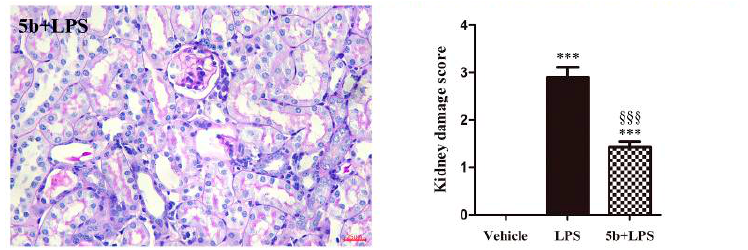
Figure 2. Effect of 5b on lipopolysaccharide (LPS)-induced acute kidney injury (AKI) mice. Periodicacid-Schiff (PAS)-stained sections showed no damage in the vehicle group, the tubular injury in LPS group, and attenuated tubular injury in the 5b + LPS group. Note there were many dilated tubules (asterisk) in LPS-induced AKI mice. Kidney damage score was expressed as means ± SD for groups of six mice. *** p < 0.001 vs. vehicle group; §§§ p < 0.001 vs. LPS group.